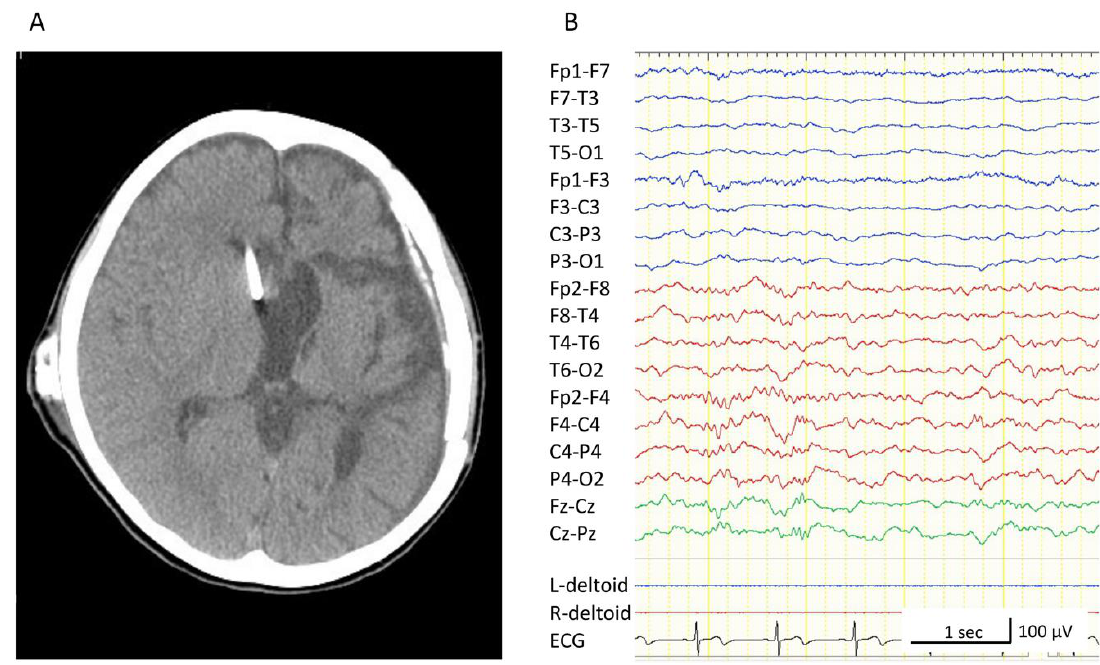
Figure 5. Brain computed tomography (CT) and scalp electroencephalogram (EEG) after the left hemispherotomy. The EEG was recorded with the following settings: low-cut filter, 1.6 Hz; high-cut filter, 60 Hz. ( A ) Brain CT after the left hemispherotomy. ( B ) Interictal EEG. The appearance of epileptiform discharges is decreased; the formation of sleep spindles is confirmed in the right hemisphere.